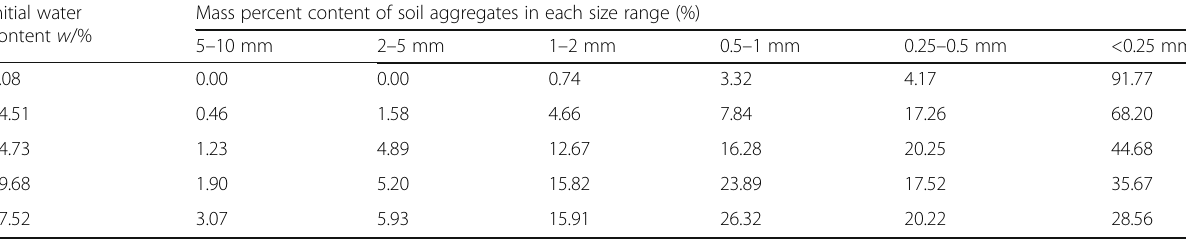
Table 4 The distribution of grain size of soil aggregates under different initial water contents Initial water content w /%